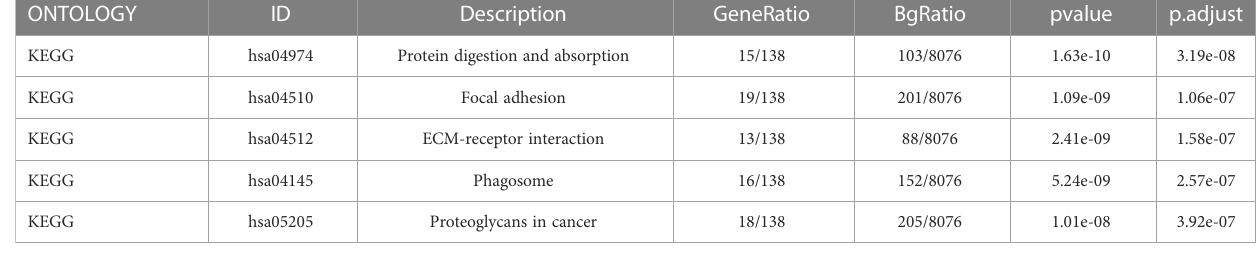
TABLE 2 Kyoto Encyclopedia of Genes and Genome enrichment (KEGG) analyses of the top 300 co-expression genes positively associated with TPM4 expression. ONTOLOGY